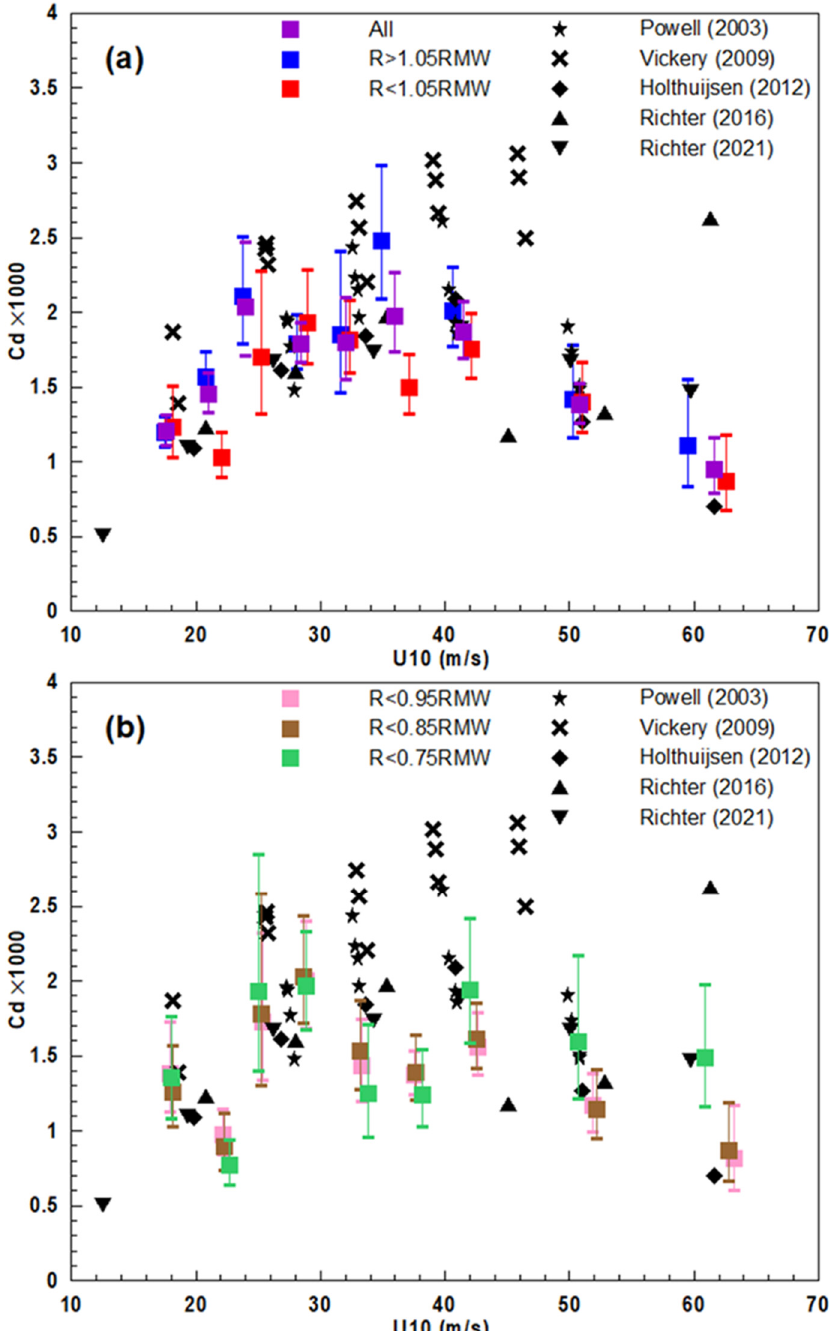
Figure 6. Same as Figure 3, but for the variation of the surface drag coefficient ( C d × 10 3 ) with 10-m wind speed ( U 10 , unit: m s − 1 ). ( a ) All, R/RMW > 1.05 and R/RMW < 1.05, ( b ) R/RMW < 0.95, R/RMW < 0.85 and R/RMW < 0.75. The various black symbols are the result from Powell et al. [11], Vickery et al. [30], Holthuijsen et al. [16], Richter et al. [27], and Richter et al.